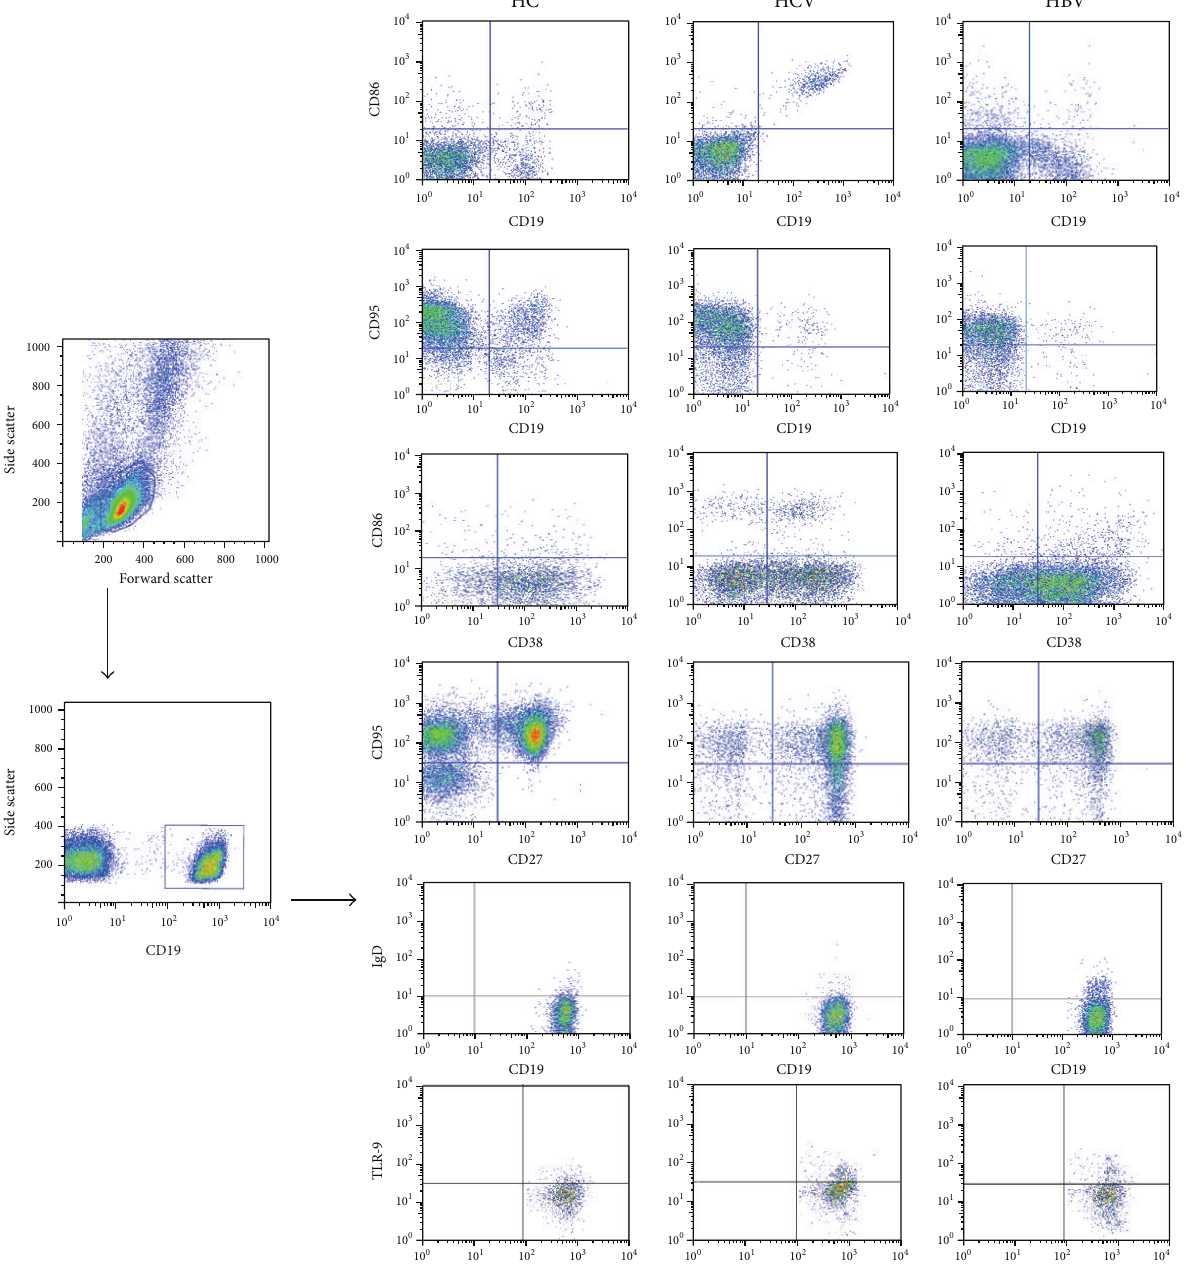
Figure 1: FACS analyses of B cells. Peripheral mononuclear cells were stained with anti-CD19, anti-CD38/27, anti-CD86/95, anti-IgD, anti- TLR-9, or isotype-matched IgG. The cells were gated initially on living lymphocytes (top left) and then on CD19+ B cells (lower left). Subsequently, the frequency of the activation marker (CD86) on total (CD19+), plasma (CD19+CD38+), and nonplasma (CD19+CD38 − ) B cells, the expression of the exhaustion marker (CD95) on total (CD19+), memory (CD19+CD27+), and naive (CD19+CD27 − ) B cells, and IgD as well as TLR-9 expressed on total (CD19+) B cells were analyzed by flow cytometry. At least 30,000 events were analyzed for each sample. Data are representatives of different groups of samples from at least two independent